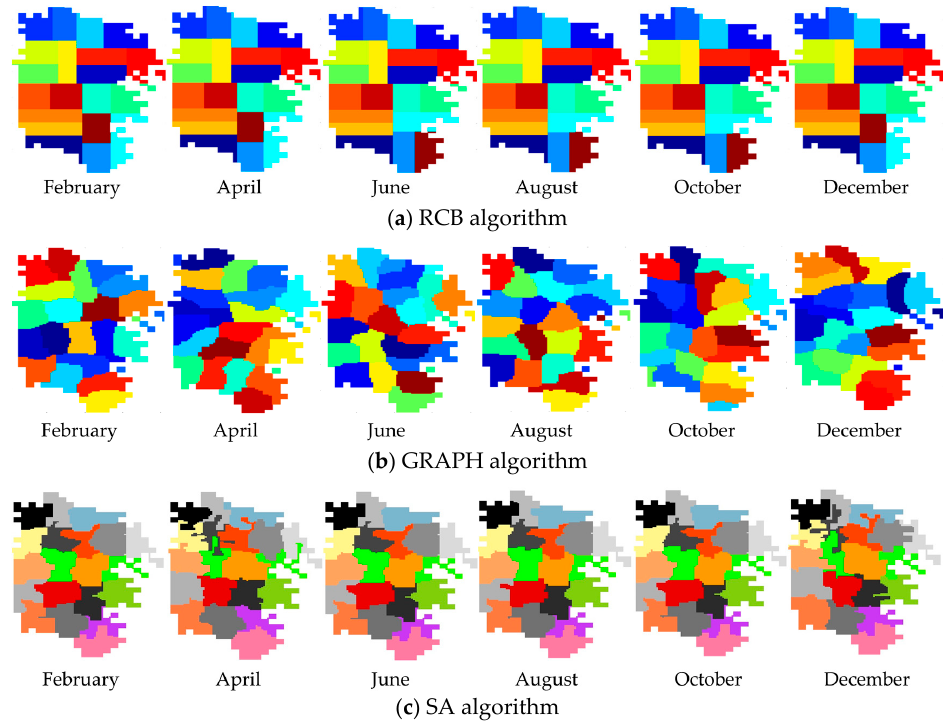
Figure 3. Community clustering results of ( a ) RCB; ( b ) GRAPH; and ( c ) SA algorithms.